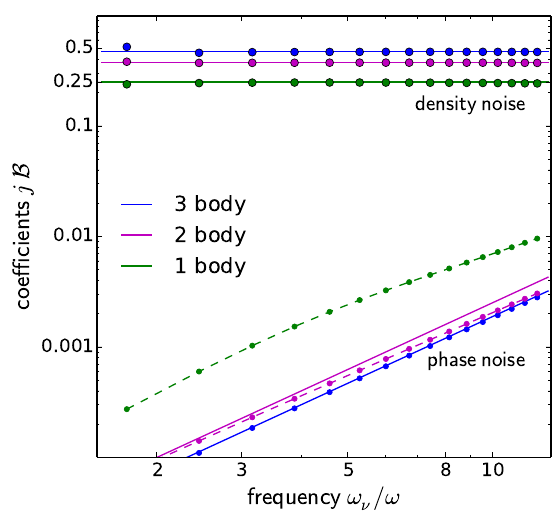
Figure 3: Diffusion of density and phase quadratures associated with many-body loss in a one-dimensional gas trapped in a harmonic potential. We plot the dimen- sionless coefficients j (cid:66) [ Eq.(25) ] and j (cid:66) ϕ [ Eq.(37) ] that are proportional to the shot noise projected onto the corresponding quadratures. Symbols: numerically computed mode functions, improving upon the hydrodynamic approximation. Solid lines: approximate results based on the Legendre modes (34). Dashed lines: guide to the eye. Parameters: strictly 1D equation of state µ = gn , peak chemical potential µ ≈ gn = 100 ħ h ω p p